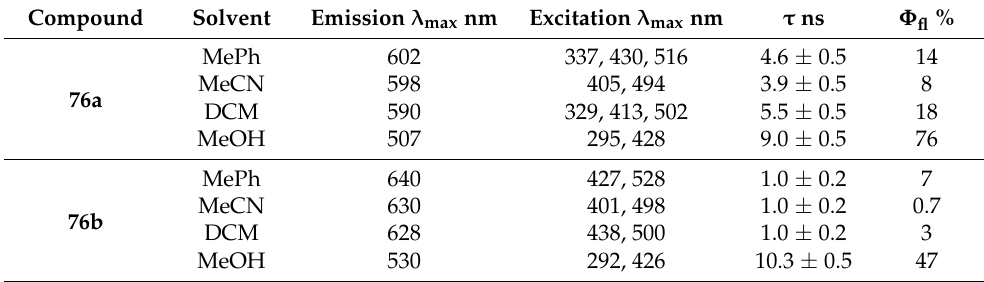
Table 13. Photophysical properties of compounds 76a – c in toluene, acetonitrile, dichloromethane (DCM) and methanol solutions at room temperature, λ ex = 420 nm. Lifetimes ( τ ) were determined at λ max of the emission